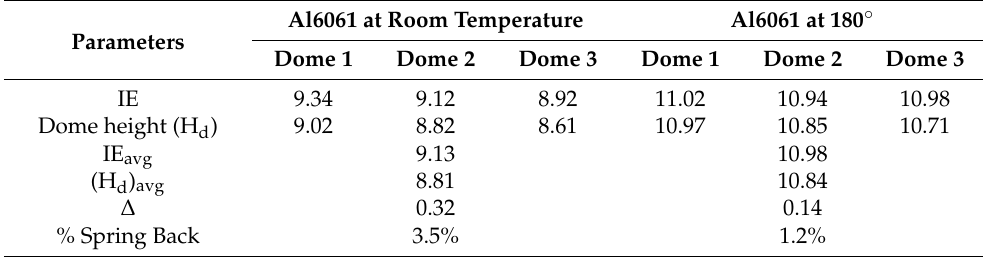
Figure 5. Domes made in Erichsen ductility test. Table 4. Erichsen ductility test of 6061 sheets.